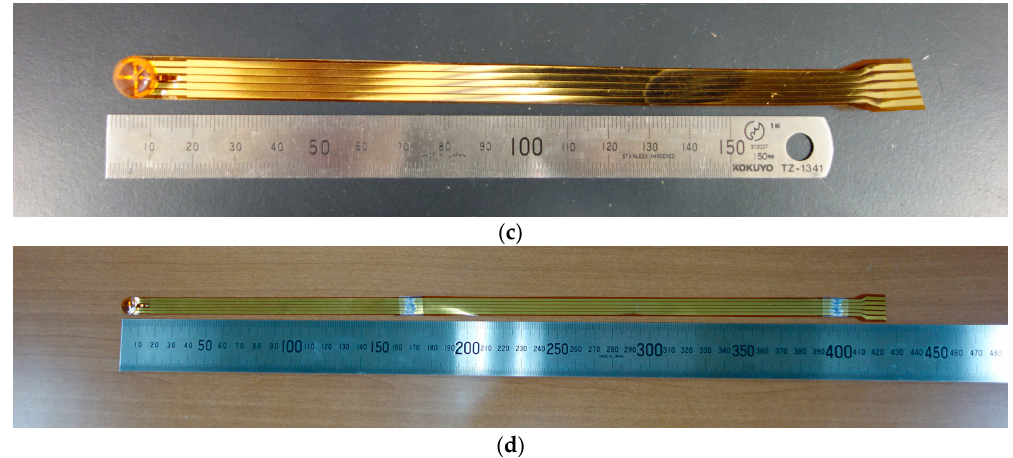
Figure 5. Photographs of the sensor: ( a ) Frontal view of the head; ( b ) Side view of the head; ( c ) Standard sensor outlook; and ( d ) Elongated sensor outlook.